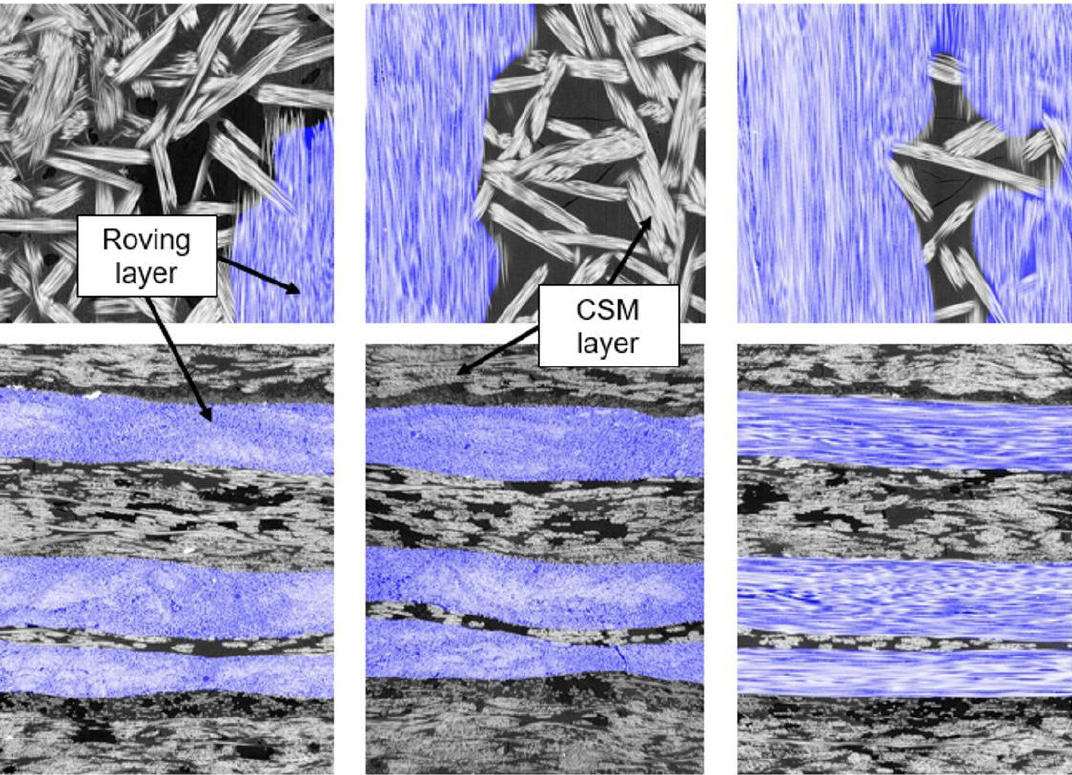
Figure 9. Results of the segmentation (of roving in blue) in different slices (different orthogonal planes) of a pultruded GFRP